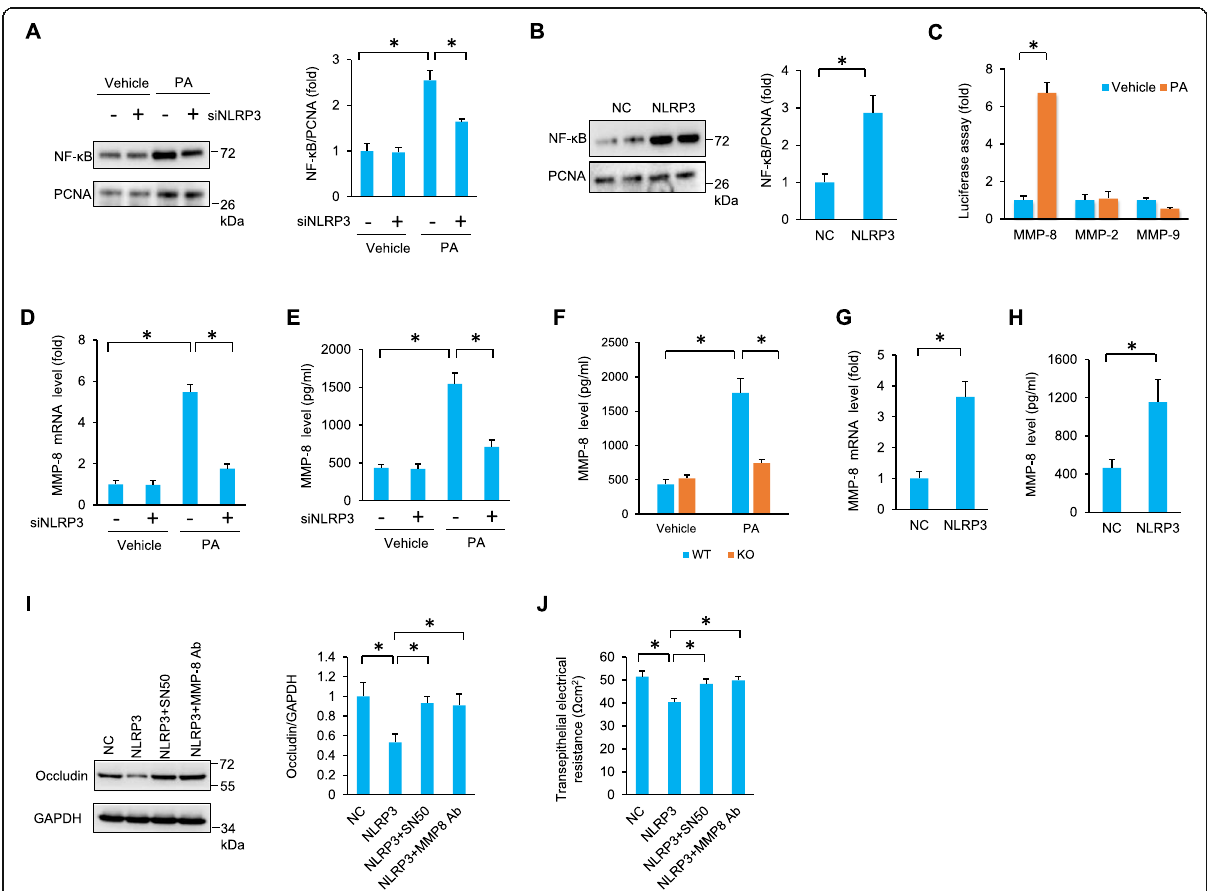
Fig. 3 NLRP3 regulated the expression of occludin via NF- κ B/MMP-8 in vitro. A The nuclear accumulation of NF- κ B was detected in TM4 cells after PA incubation for 24 h ( n = 6). B The nuclear accumulation of NF- κ B was detected in TM4 cells at 48 h after NLRP3 overexpression ( n = 6). C The luciferase assay revealed the binding of NF- κ B to the promoter of MMP-8 in TM4 cells after PA incubation for 24 h ( n = 6). D – E MMP-8 mRNA and expression in TM4 cells after PA incubation for 24 h ( n = 6). F MMP-8 expression in isolated NLRP3-deficient SCs after PA incubation for 24 h ( n = 4 – 5). G , H MMP-8 mRNA and expression in TM4 cells after NLRP3 overexpression ( n = 6). I The protein expression of occludin in TM4 cells at 48 h after SN50 or MMP-8 blocking peptide incubation ( n = 6). J Transepithelial electrical resistance was detected in TM4 cells at 48 h after SN50 or MMP-8 blocking peptide incubation ( n = 6). Data are presented as the mean ± SD. For B, C and G , H , the statistical analysis was carried out by Student ’ s two-tailed t test; for others, statistical analysis was carried out by one-way ANOVA. * P < 0.05 vs the matched